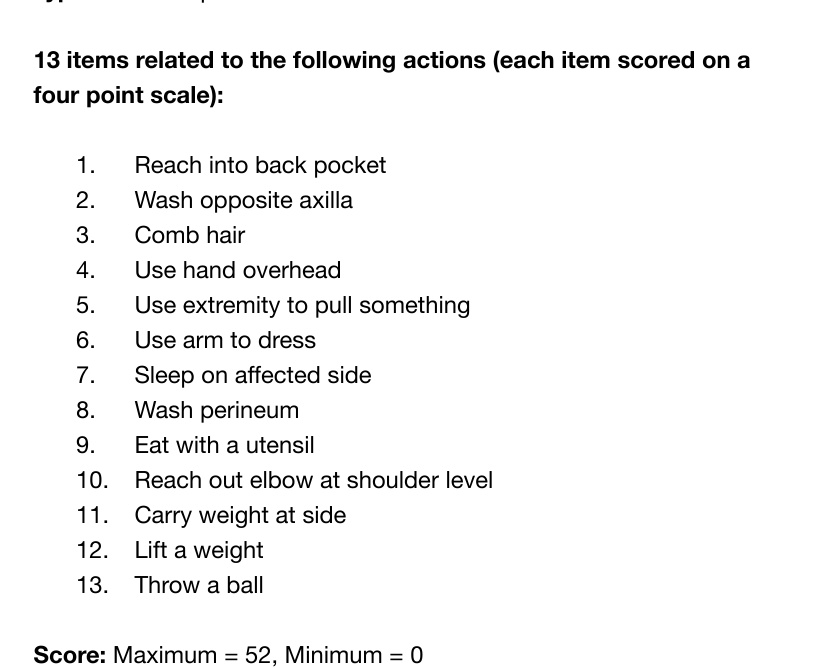
Figure 2: Harryman Rotator Cuff Functional Assessment